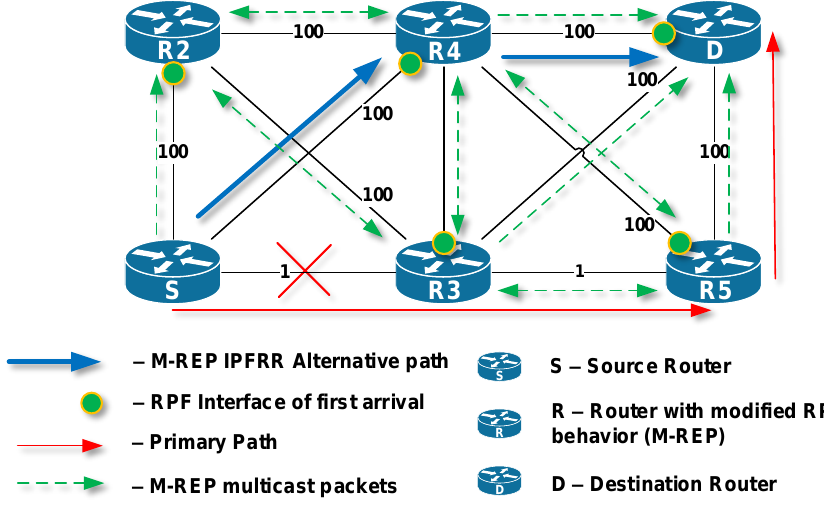
Figure 3. The first arrival rule.